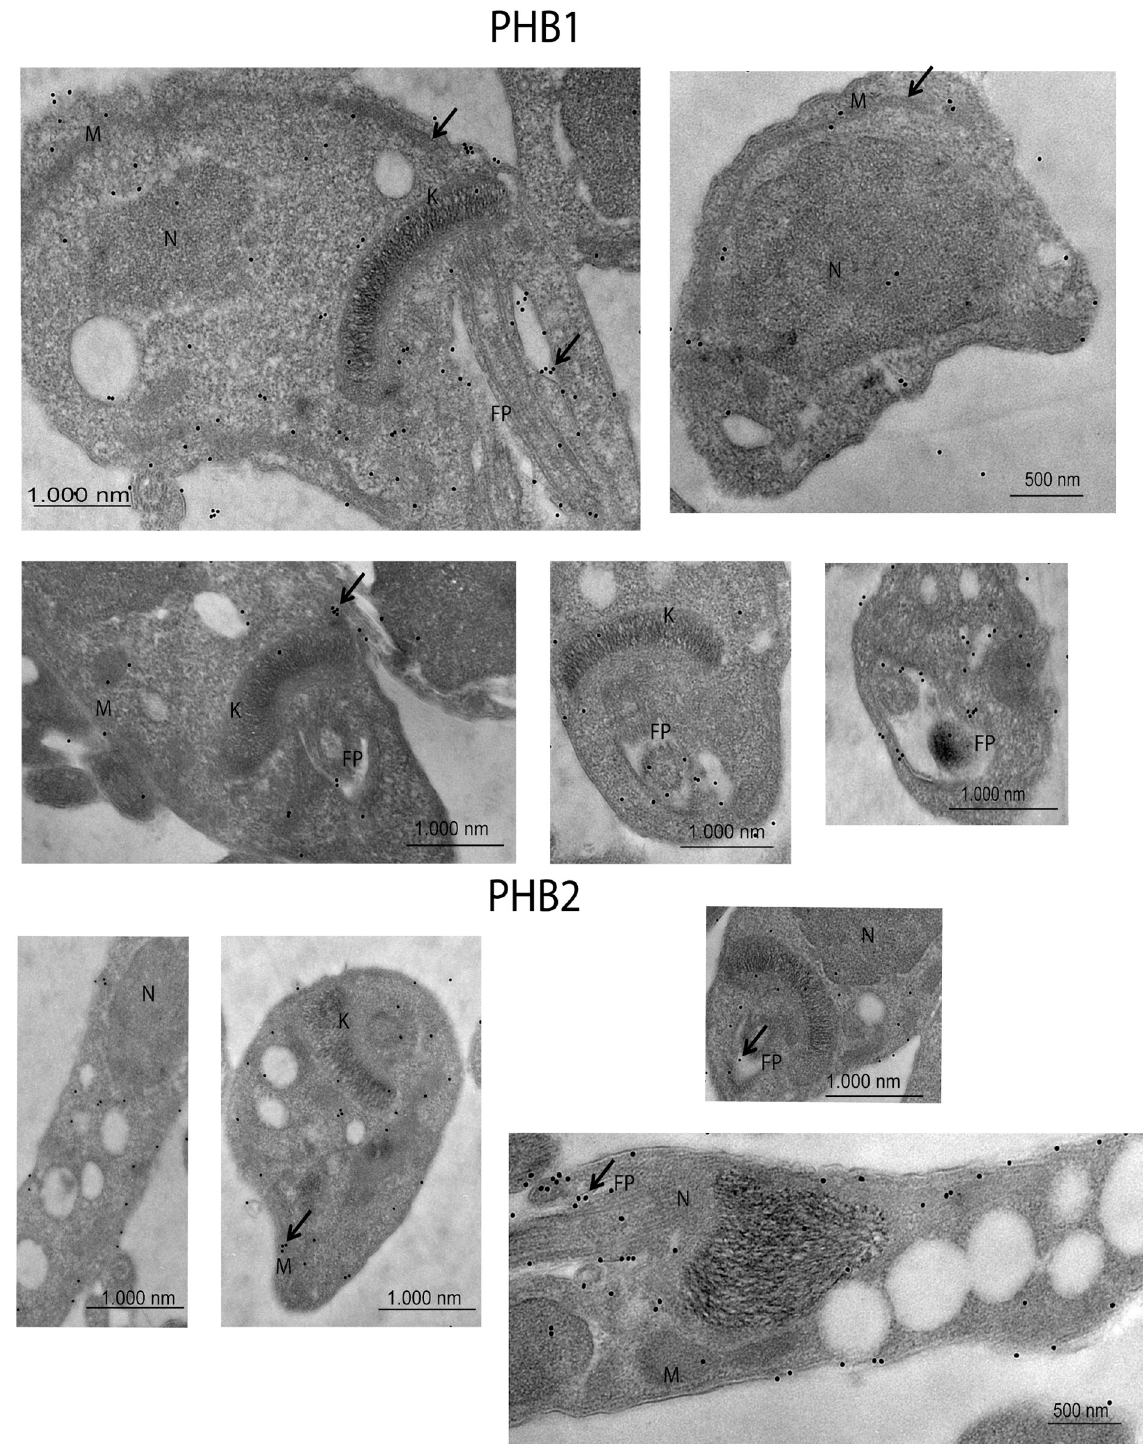
Fig 5. Immunolocalization of PHB1 and PHB2 in epimastigote forms of T . cruzi by electron microscopy. Ultrathin sections were incubated with anti-PHB1 and anti-PHB2 antibodies, followed by secondary antibodies coupled to 10 nm or/and 18 nm gold particles. Images of control sera are shown in S4 Fig samples incubated with pre-immune sera; control 2: samples incubated only with the secondary antibody. Representative images are shown. K: kinetoplast, M: mitochondria, N: nucleus, FP: flagellar pocket, The control images using the preimmune sera or from non-immunized animals are shown in S4 Fig.